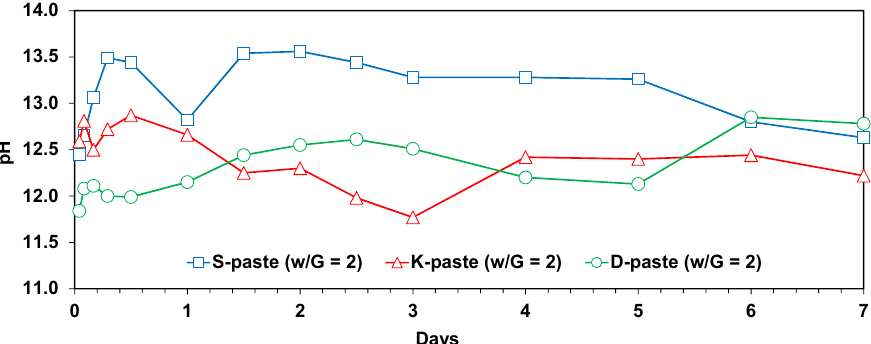
Figure 5. Temporal changes in pH values of diluted pastes of GGBFS powders (w/G = 2) for seven days.